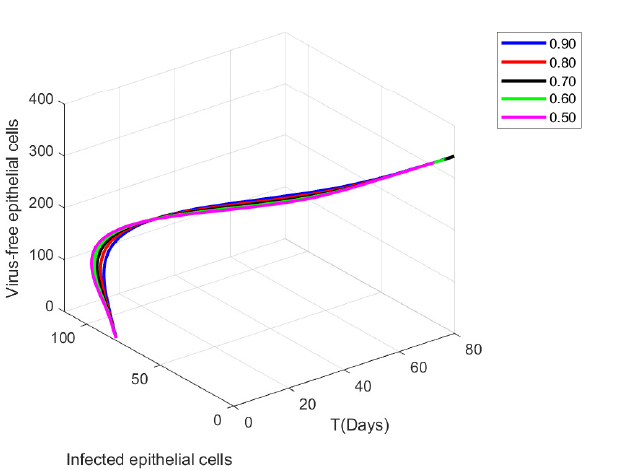
Figure 7. Graphical representation of the virus-infected epithelial cells and virus-free epithelial cells for fractional order α = 0.9, 0.8, 0.7, 0.6, 0.5 when R 0 <